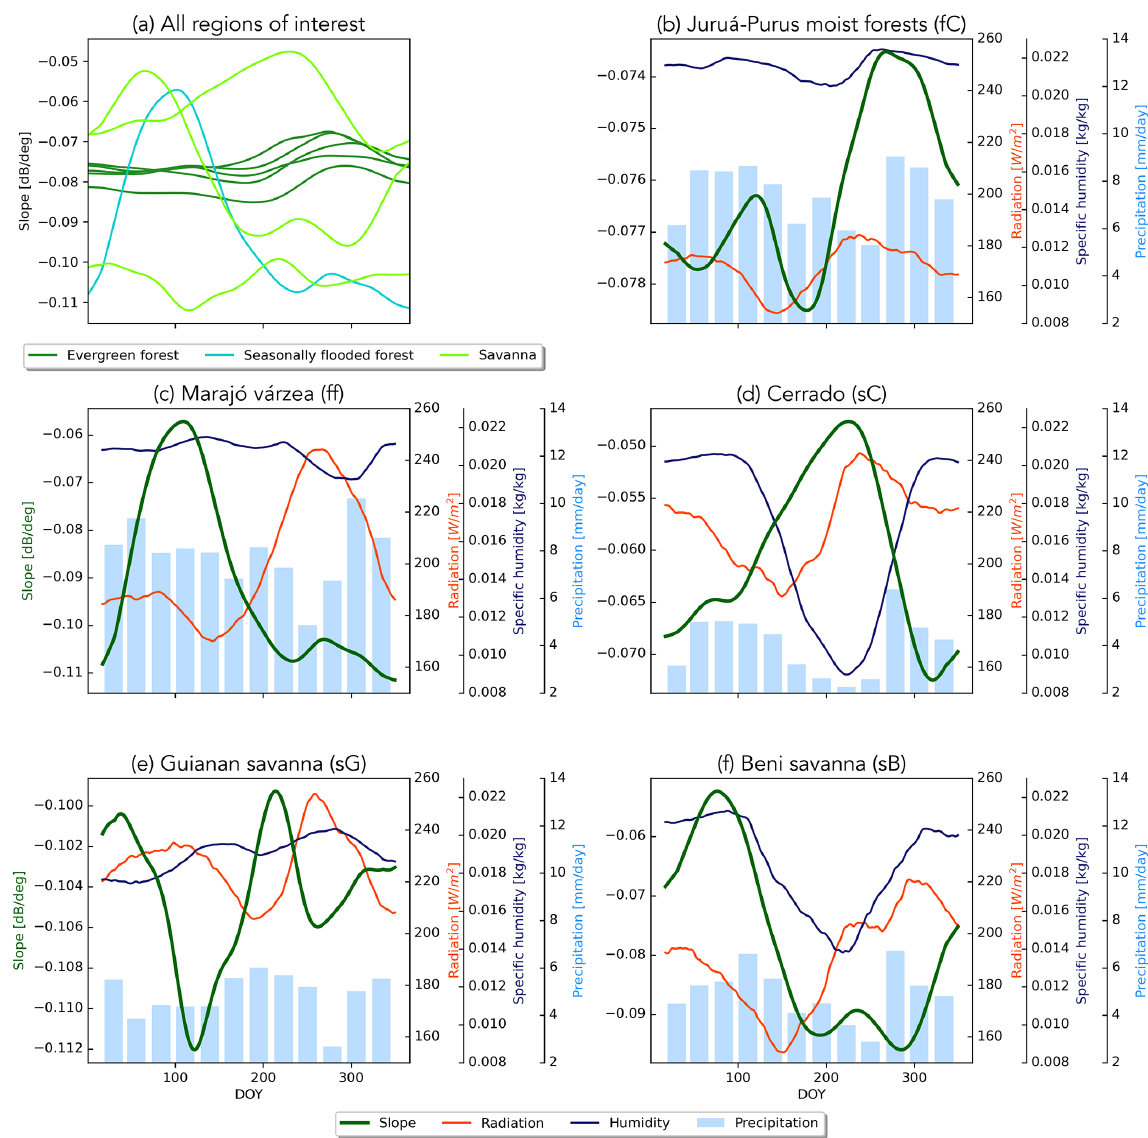
Figure 5. Climatologies of the slope for all ecoregions, with five evergreen forests (dark green), flooded forests (cyan), and three savannas (light green) (a) . Panels (b) – (f) show the climatology of the slope (green line) with precipitation (bars) and specific humidity (blue line) and radiation (red line) per ecoregion. Note the different y axes and that only the Juruá–Purus moist forest (fC) is shown, as it is similar to the other evergreen